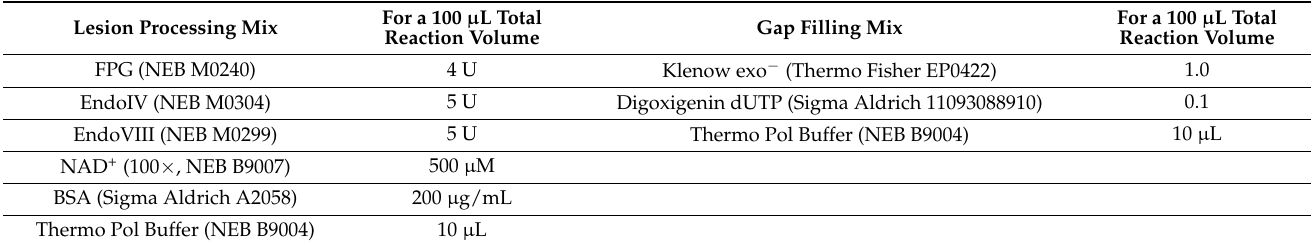
Table 2. Oxidative lesion RADD (oxRADD) assay